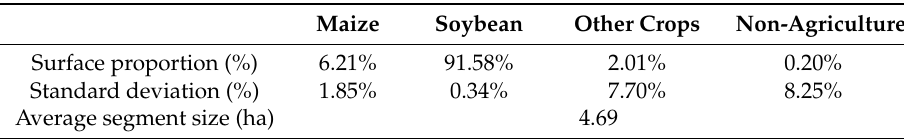
Table 1. Statistics on the 202 segment survey.